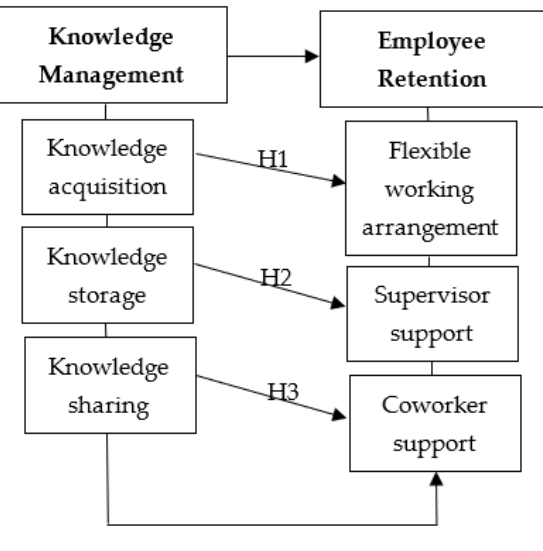
Figure 1. Conceptual